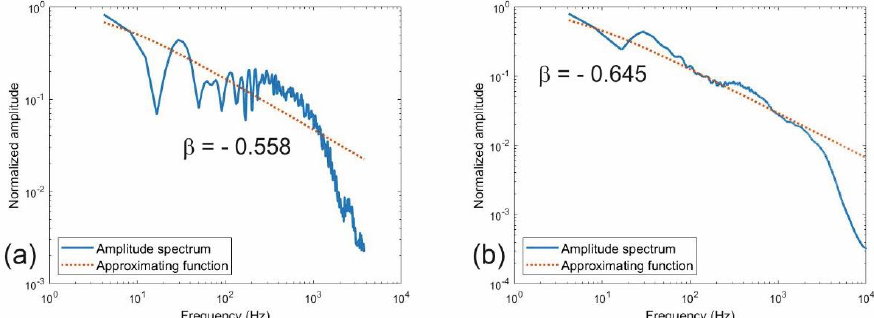
Figure 9. Normalized amplitude spectra for two intersecting profiles with enveloped Chirp ( a ) and enveloped Boomer data ( b ) plotted by continuous blue lines in a logarithmic scale. The approximating function | ω | β is represented by the dotted orange line. Notice the different b values in the two cases, and the closer match of the enveloped Boomer data ( b ) to the approximating function.